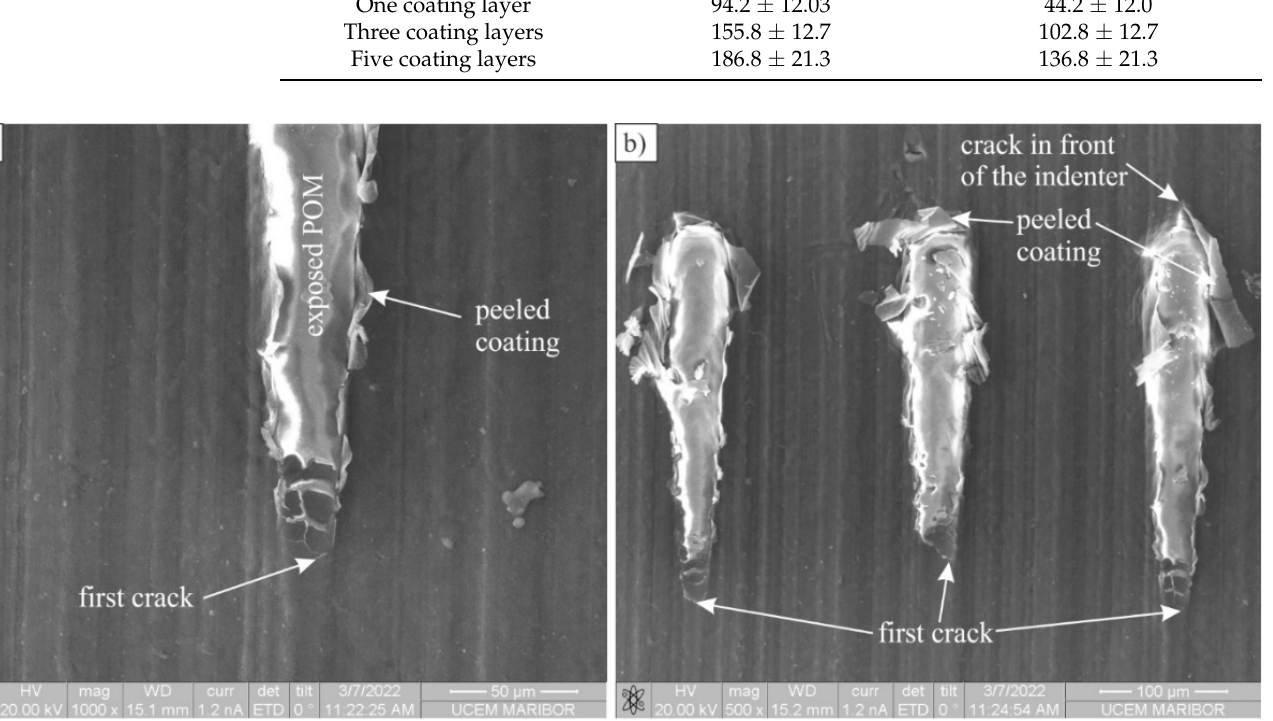
Figure 7. Backscattered electron micrographs of scratch tracks showing the damage: ( a ) A detailed view of the scratch beginning; ( b ) Damage caused by the indenter in the POM, coated with one layer of Al.